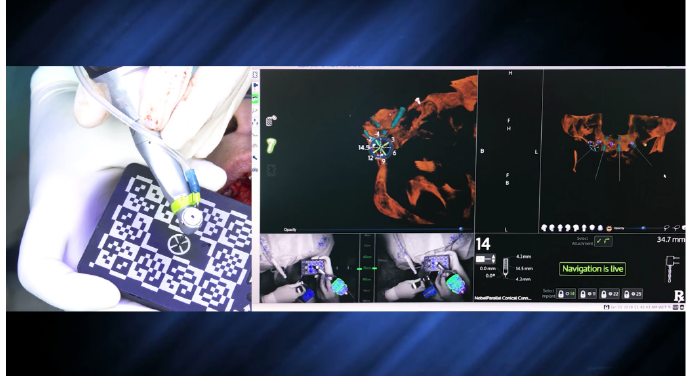
Figure 10. Spatial calibration of the 2.0 mm drill using an array immediately before the preparation.